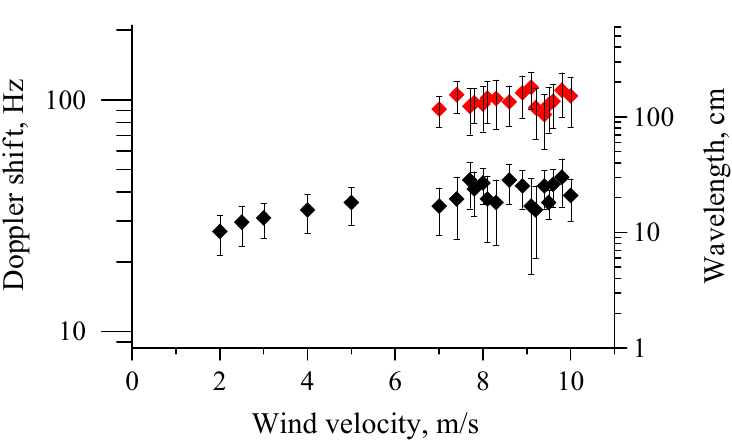
Figure 12. Doppler shifts in the background and in the spikes (black and red symbols, respectively) and the lengths of waves responsible for scattering. Confidence intervals of 95% are depicted for the